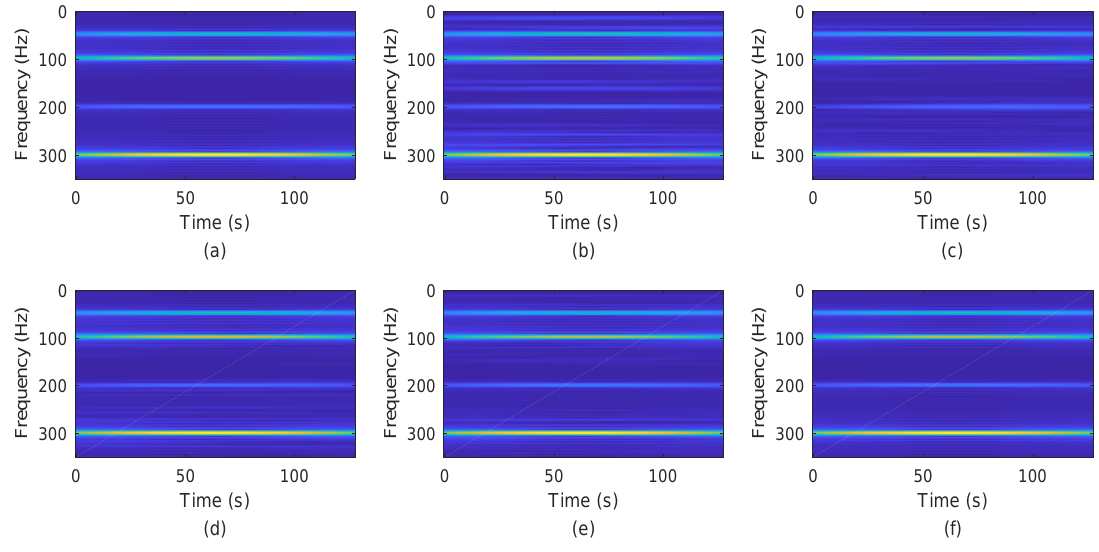
Figure 4. Frequency spectrum analysis of the original signal and the signal recovered by BPDN, SL0, NSL0, L p -RLS, and WReSL0 when noise intensity δ N = 0.2. ( a ) original signal; ( b ) signal recovery by the BPDN algorithm; ( c ) signal recovery by the SL0 algorithm; ( d ) signal recovery by the NSL0